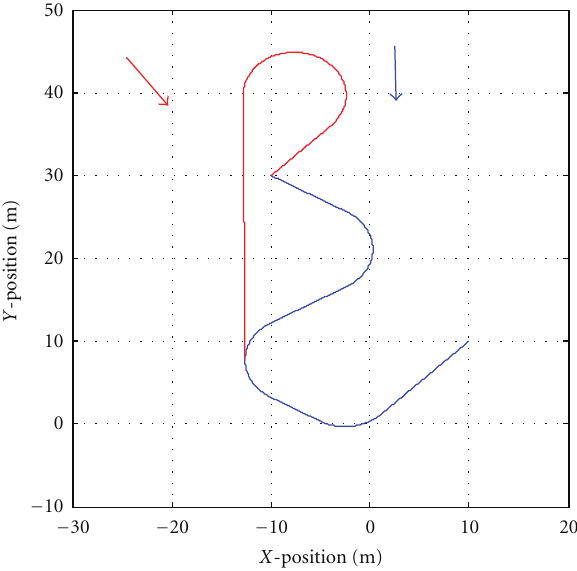
Figure 9: Trajectories followed by the vehicle when the wind shifts. Blue and red arrows indicate that the wind direction